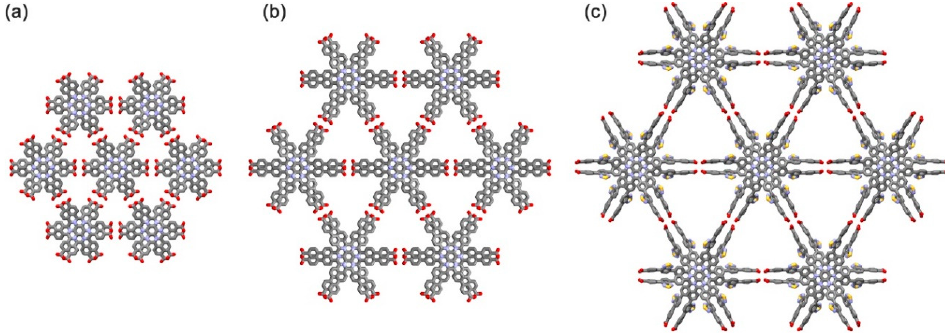
Figure 6. Crystal structures of HAT-based HOFs: ( a ) CPHAT-1; ( b ) CBPHAT-1; ( c ) ThiaHAT-1. Addition of three benzenes at the HAT unit led to the corresponding carboxyphenyl- substituted hexaazatrinaphthylene derivative (CPHATN) as the fundamental unit (Figure 1) [79].